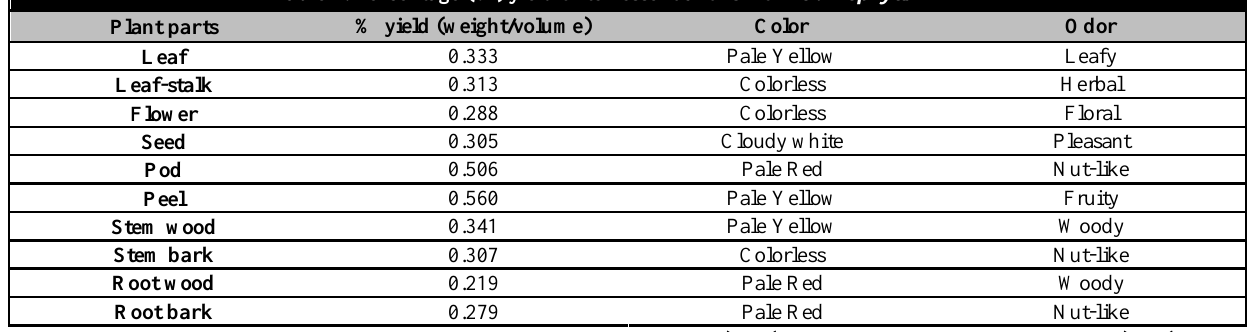
Table 1. Percentage (%) yield of ten essential oils from C. Inophyllum Linn Plant parts